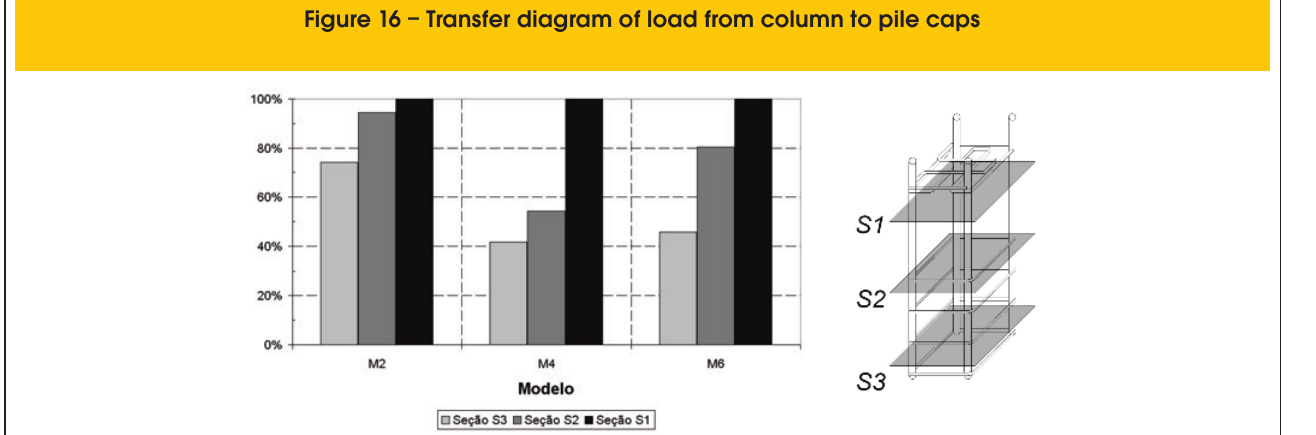
Figure 16 – Transfer diagram of load from column to pile